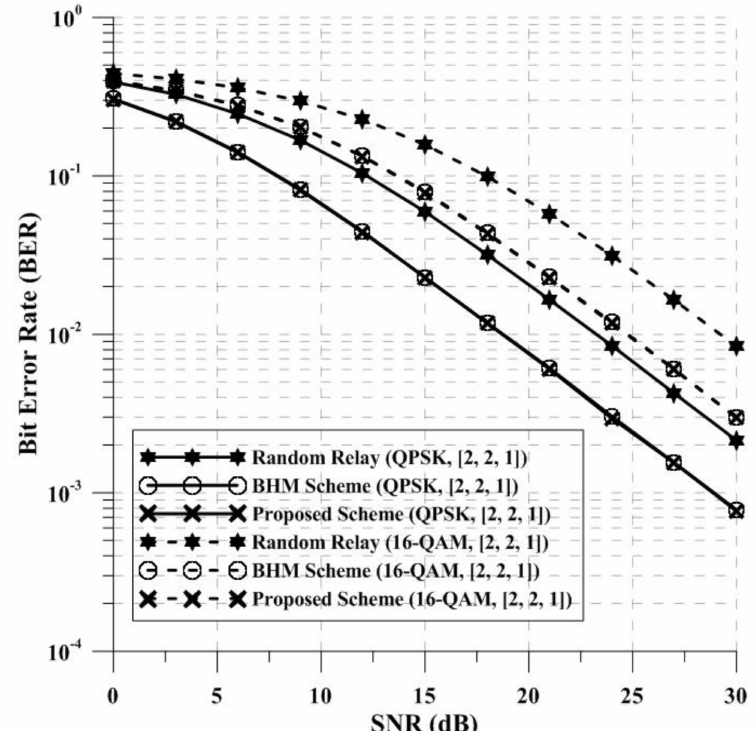
Figure 5. The BER performance of the proposed and conventional schemes in 2D channel environment = 1 ) . ( N t = 2, N r = 2, N UE